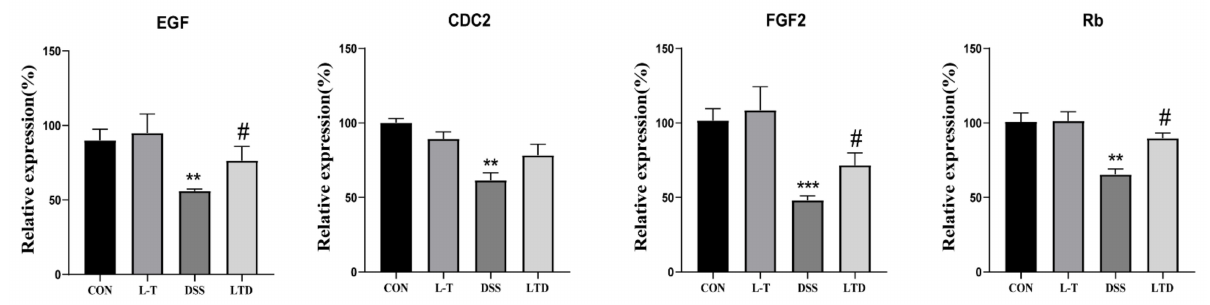
Figure 5. Effect of L-theanine on the proliferation-related genes expression of IPEC-J2 cells induced by DSS. The mRNA rela- tive expression of the cell cycle-related genes EGF, CDC2, FGF2, and Rb were detected using RT-PCR assay ( n = 6). ** P < 0.01 and *** P < 0.001, compared with the CON group. # P <